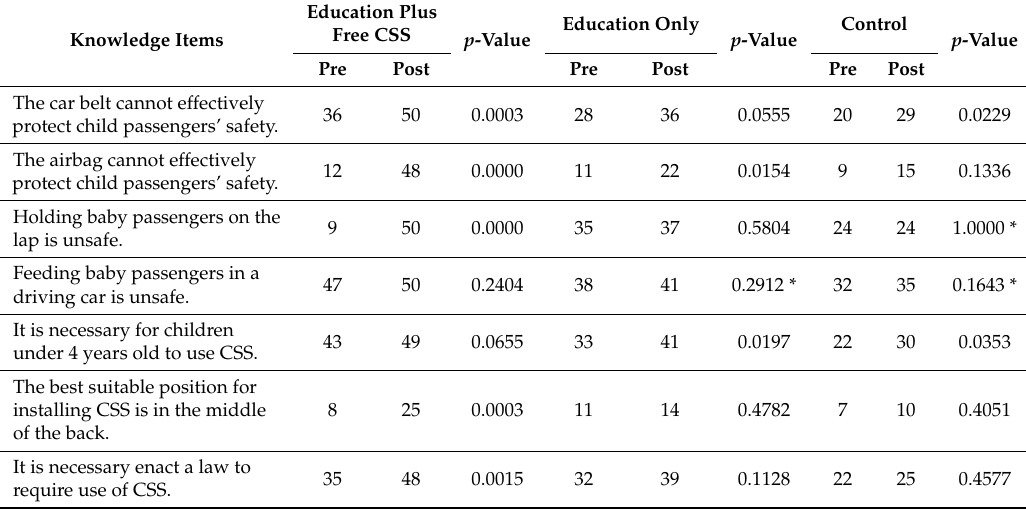
Table 3. The pre- and post-intervention comparative results on child passenger safety knowledge among three